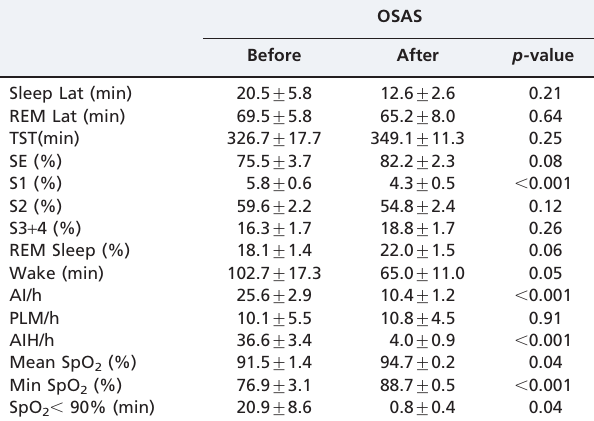
Table 4 - Polysomnographic data before and after Continuous Positive Airway Pressure treatment in the obstructive sleep apnea syndrome (OSAS) group